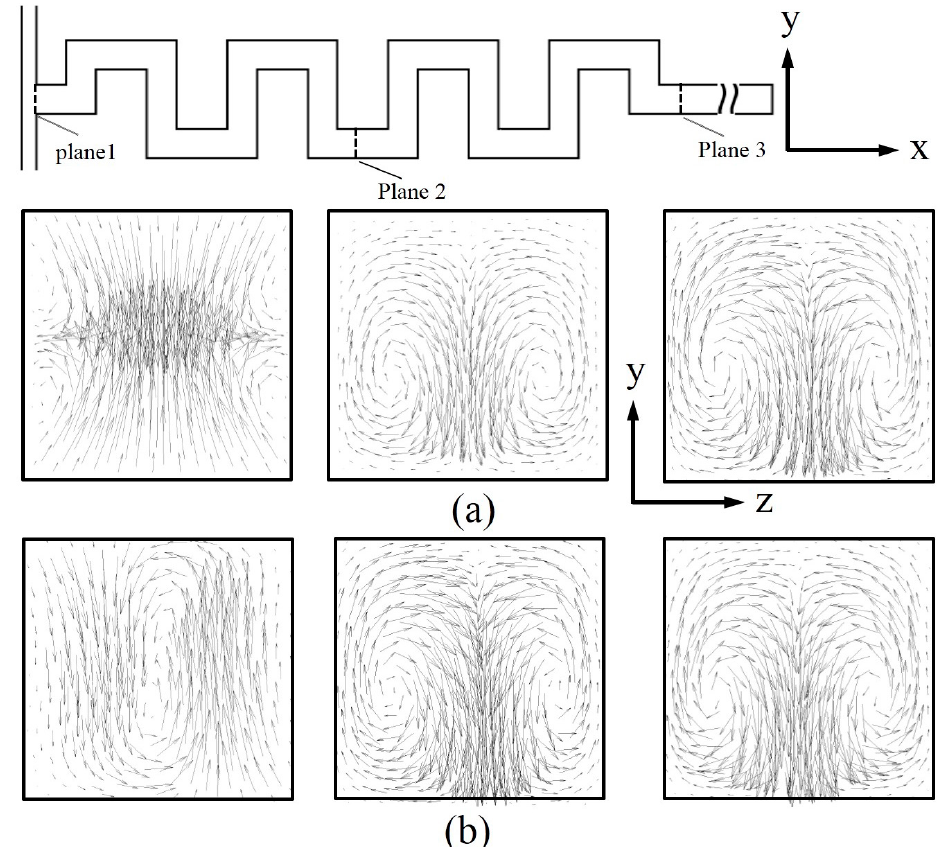
Figure 9. Velocity vectors on y – z planes for Reynolds number, 30 (Planes 1, 2, and 3 from left to right, respectively) : ( a ) Micromixer with simple T -joint inlets; and ( b ) micromixer with tangentially aligned input